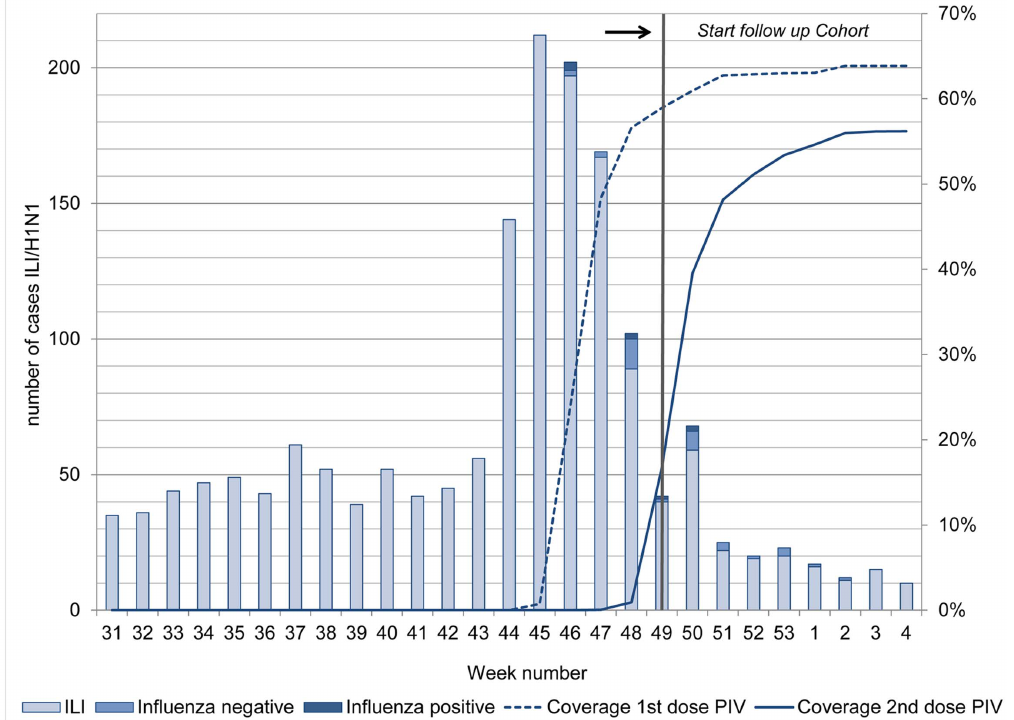
Figure 2. Influenza vaccination in relation to the pandemic curve. Coverage of the 1 st and 2 nd dose of the influenza A(H1N1)pdm09 vaccine, ILI cases in the cohort, and influenza positive cases plus controls (influenza negative) from the nested case control study against calendar time.